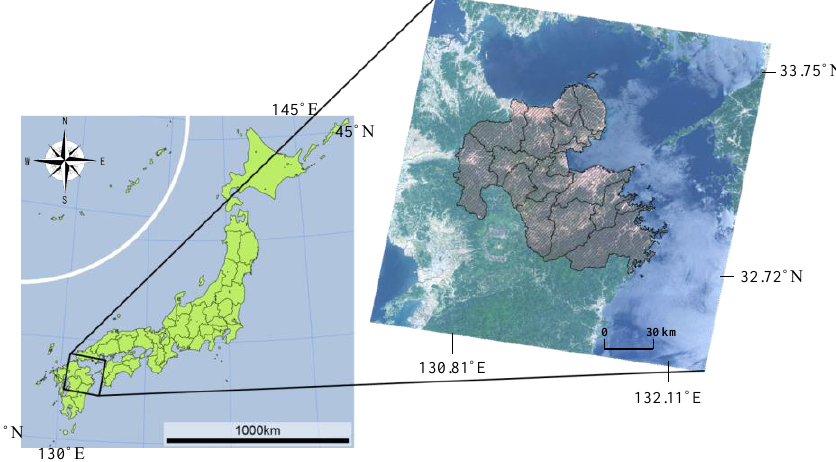
Figure 2. Location of the study area (Oita Prefecture, Japan). The enlarged image of Oita Prefecture with its administrative units (cities, towns and villages) is shown on the